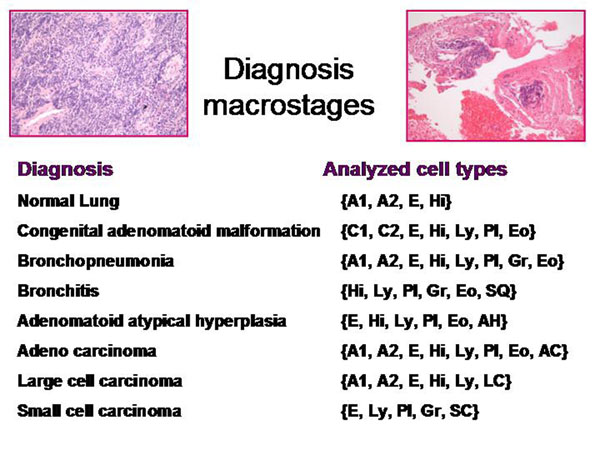
Used cell types for entropy calculation in relationship to the diagnosis (macrostage)